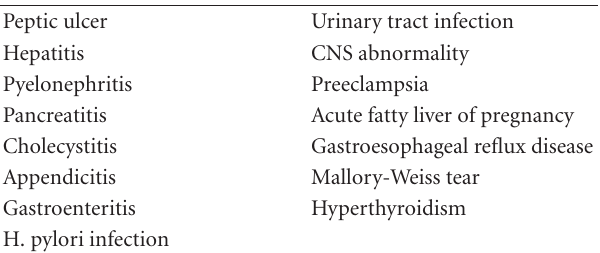
Table 1: Di ff erential diagnosis of